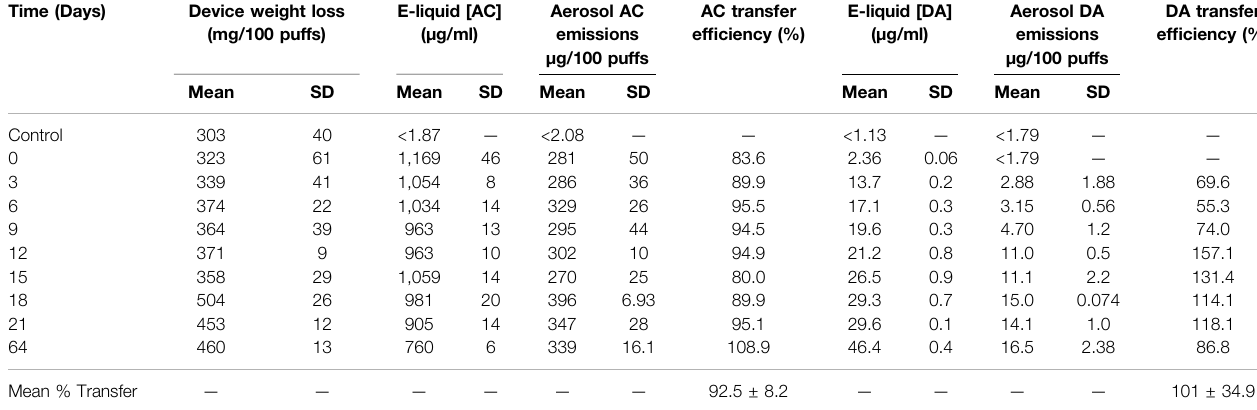
TABLE 1 | Transfer of AC from e-liquid to e-cigarette aerosol.